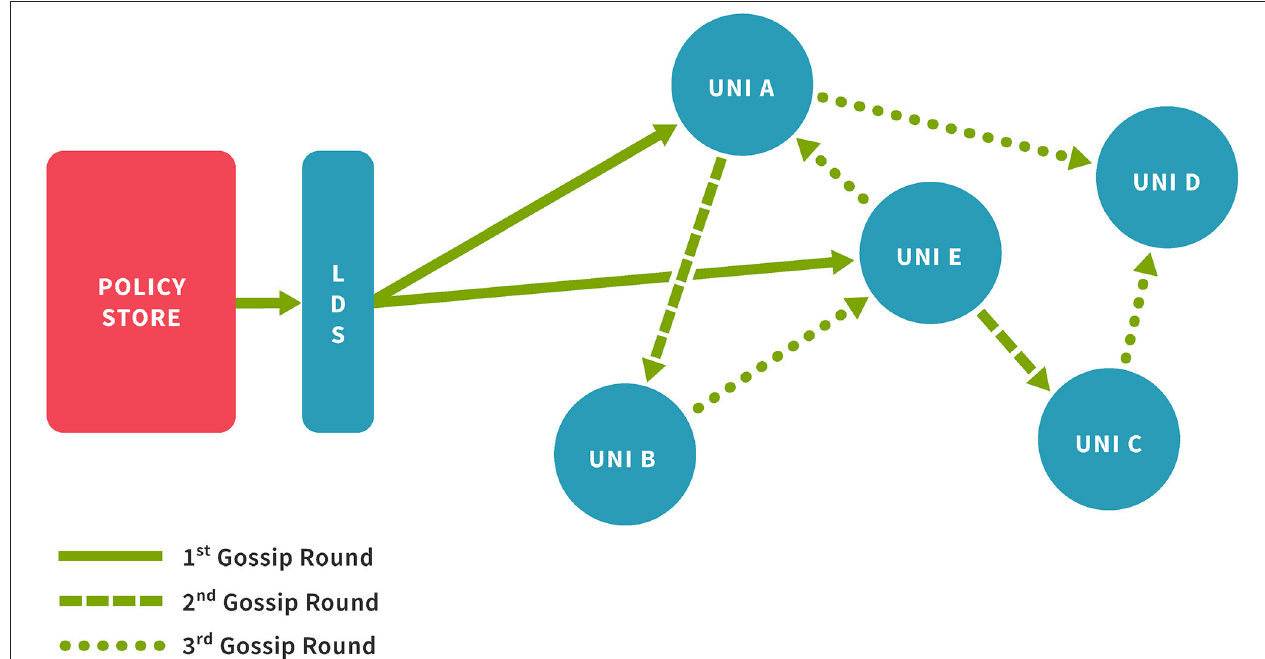
FIGURE 3 | Disseminating a policy update as a gossip in